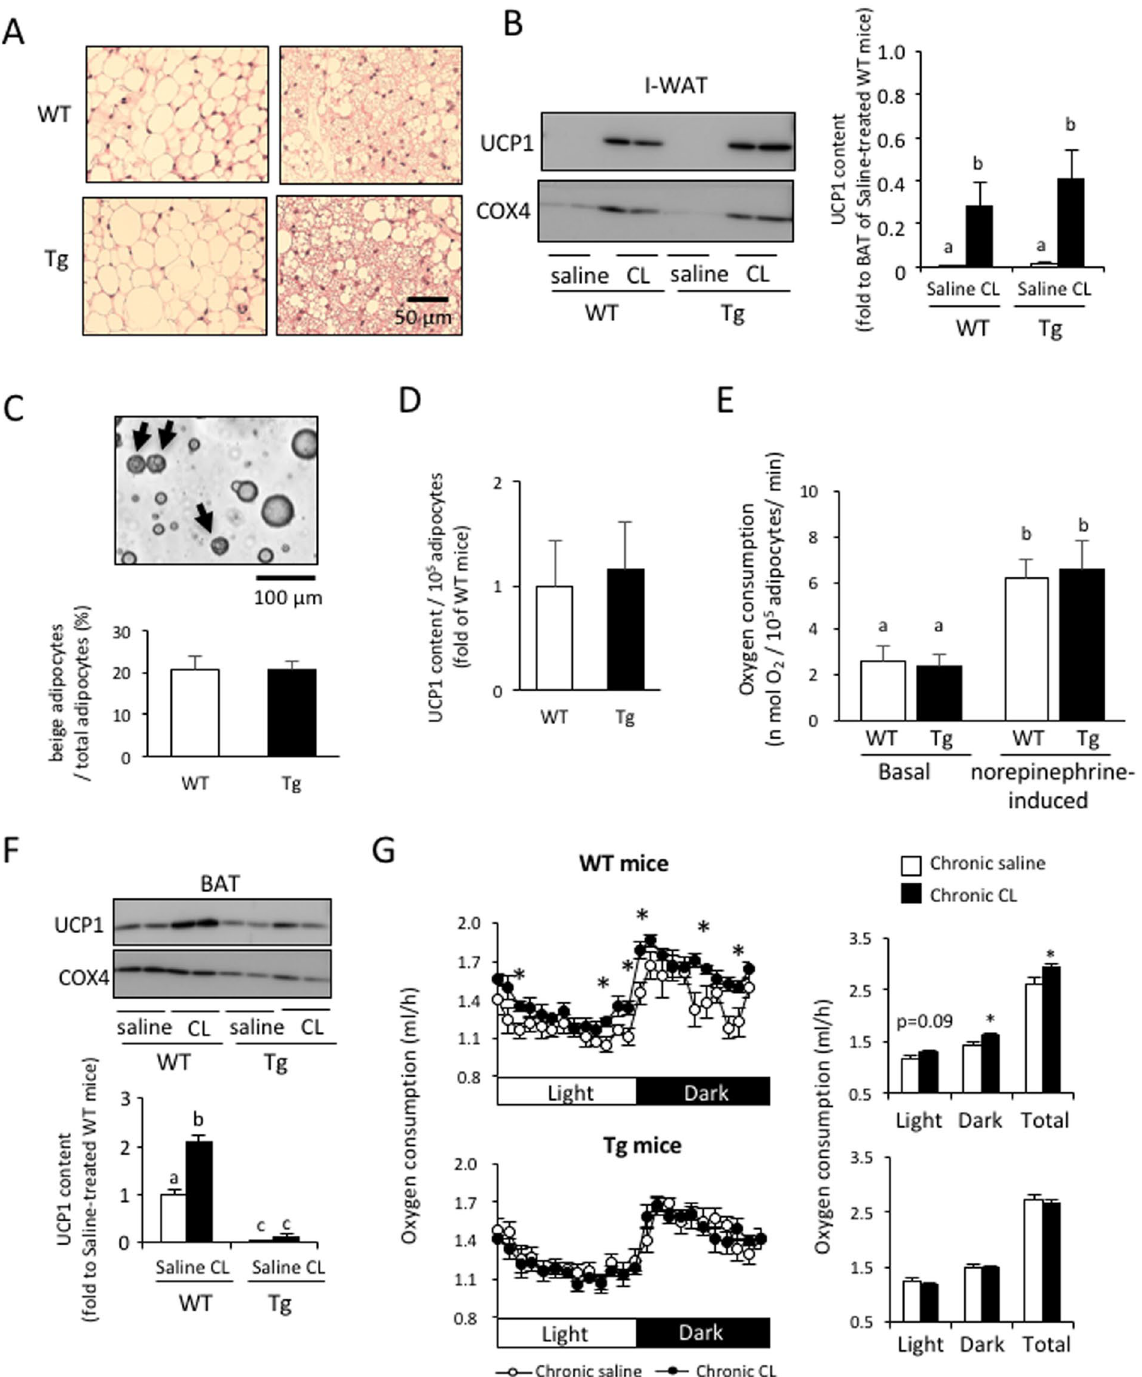
Figure 5. Transgenic expression of p27 driven by the aP2 promoter did not affect the generation and function of beige adipocytes. Mice acclimated to a room temperature of 28 °C were injected with saline or CL316,243 (CL; 1 mg/kg/day, s.c.) for 14 days. ( A and B ) Representative histological images ( A ) and measurement of the UCP1 content per inguinal-WAT (I-WAT) ( B ) show that there were no differences between WT and Tg mice with regard to the induction of beige adipocytes by CL. ( C – E ) Analysis of adipocyte fractions isolated from the I-WAT of WT and Tg mice after CL treatment showed the presence of a similar number of multilocular beige adipocytes ( C ), similar levels of UCP1 ( D ), and consumption of a similar amount of oxygen in either the basal or norepinephrine-induced state ( E ). ( F ) Chronic CL treatment failed to increase levels of UCP1 per BAT in Tg mice. (n = 6 per group, one-way ANOVA followed by the Tukey–Kramer post-hoc test, different letters indicate significant differences between groups, p < 0.05). ( G ) Enhancement of oxygen consumption after chronic CL treatment was observed in WT mice but not in Tg mice (n = 6 per group, Student’s t-test, * p <